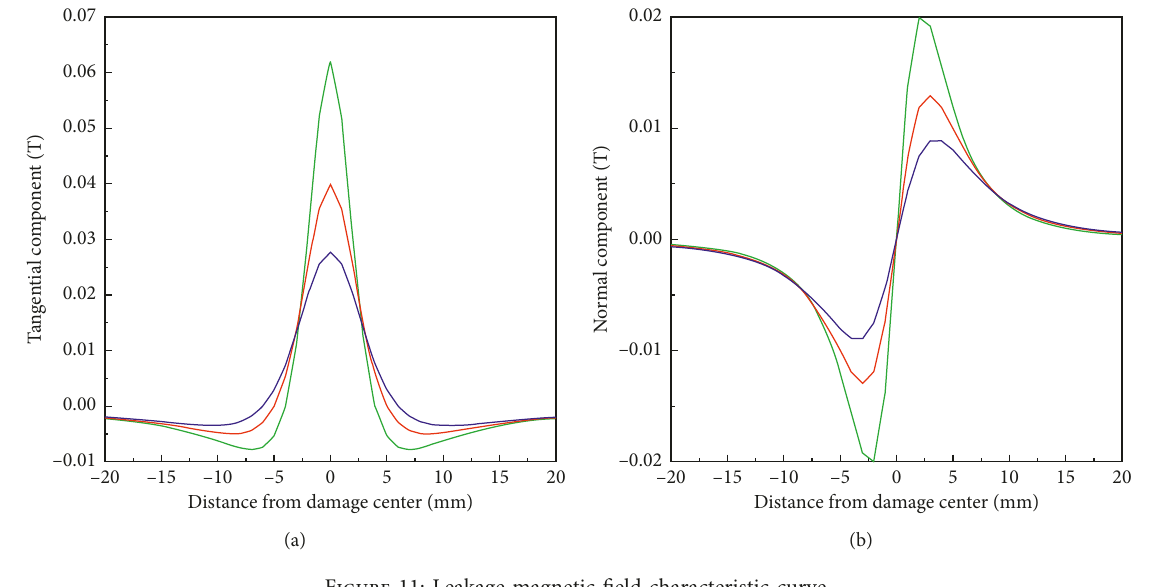
Figure 11: Leakage magnetic field characteristic